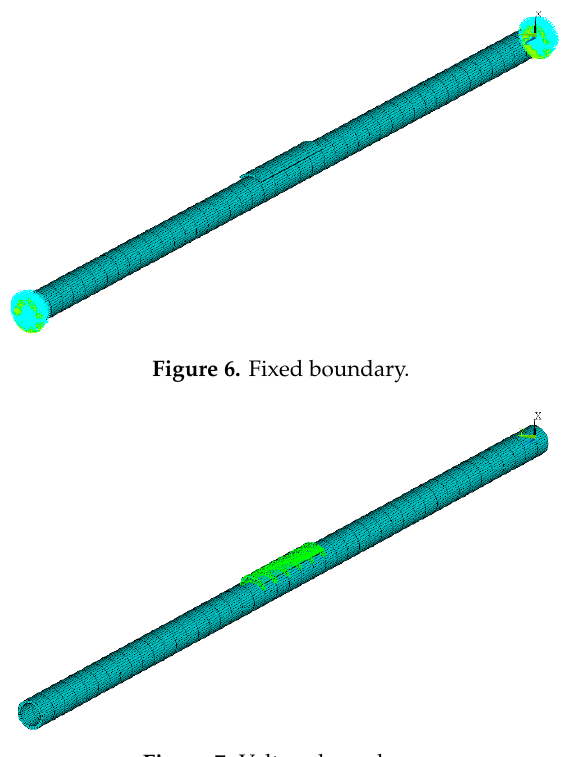
Figure 7. Voltage Figure 7. Voltage boundary. Figure 7. Voltage boundary.